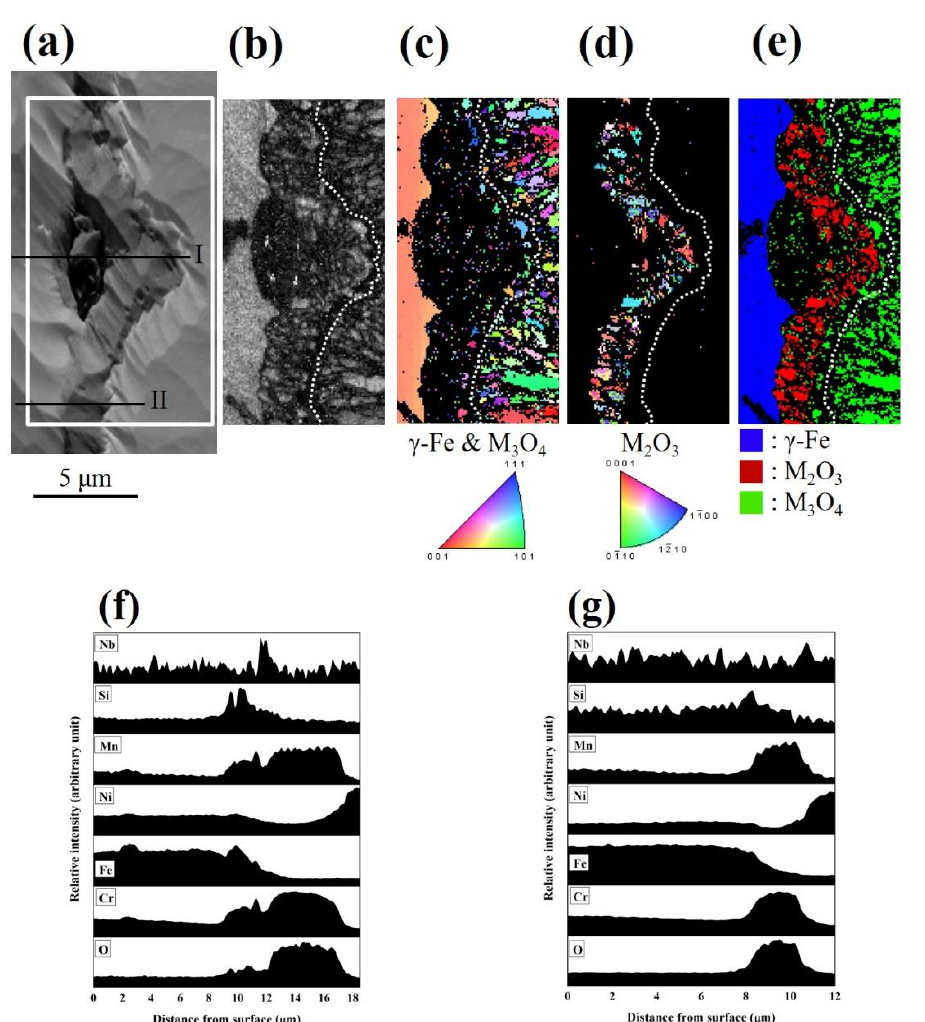
Figure 6. ( a ) FSD image, ( b ) image quality map, ( c ) inverse pole figure map for γ and M 3 O 4 phases, ( d ) inverse pole figure map for M 2 O 3 phase, and ( e ) phase map of the oxide layers in 22Cr25NiWCoCu stainless steel with 0.29% Nb after oxidation in ambient air for 150 h. ( f ) EDS line scan of Si, Mn, Ni, Fe, Cr, and O along lines I and II in ( a ) and ( g ) EDS line scan of Si, Mn, Ni, Fe, Cr, and O along line II in ( a ).